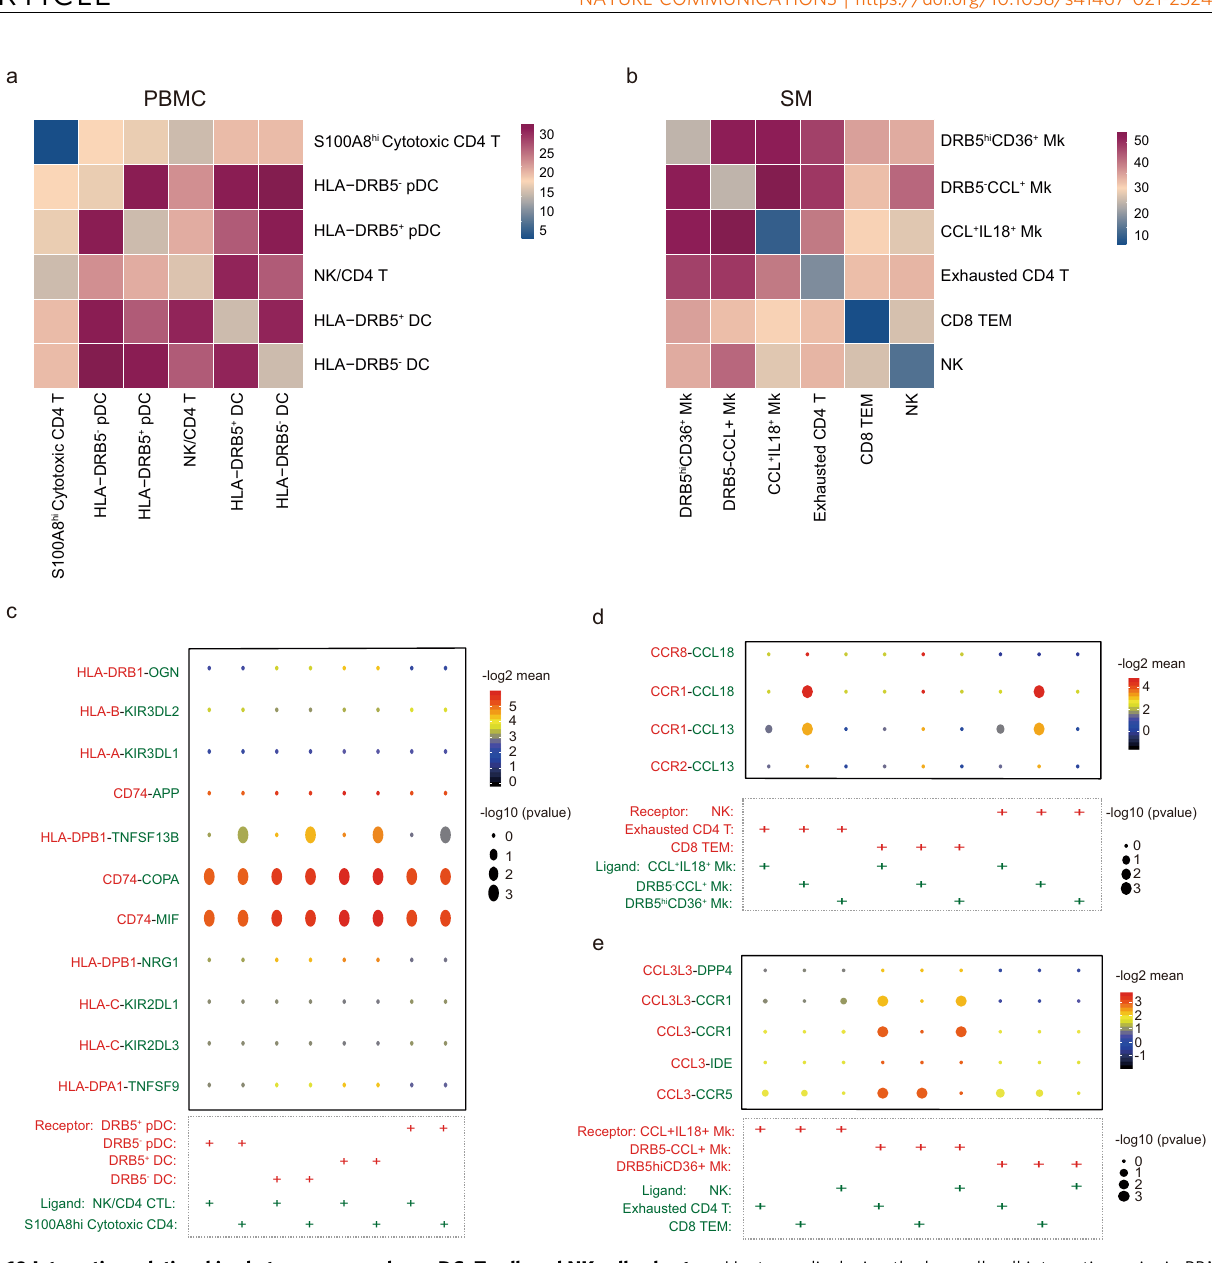
Fig. 10 Interaction relationships between macrophage, DC, T cell, and NK cell subsets. a Heatmap displaying the key cell-cell interaction pairs in PBMC. b Heatmap displaying the key cell-cell interaction pairs in the synovium. c Dot plot showing the signi fi cant ligand-receptor pairs involved in the interaction between DC subsets and CD4 T cell subsets. d Dot plot showing the signi fi cant ligand-receptor pairs involved in the interaction between macrophage subsets and T cell or NK subsets. (Ligand: T cell or NK subsets, Receptor: Macrophage subsets). e Dot plot showing the signi fi cant ligand-receptor pairs involved in the interaction between T cell or NK subsets and macrophage subsets. (Ligand: Macrophage subsets, Receptor: T cell or NK